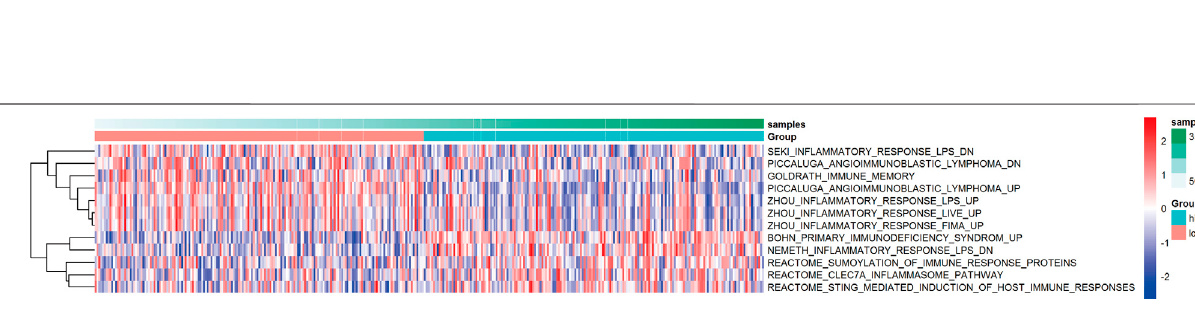
FIGURE 7 | Variation of immune and in fl ammation-related